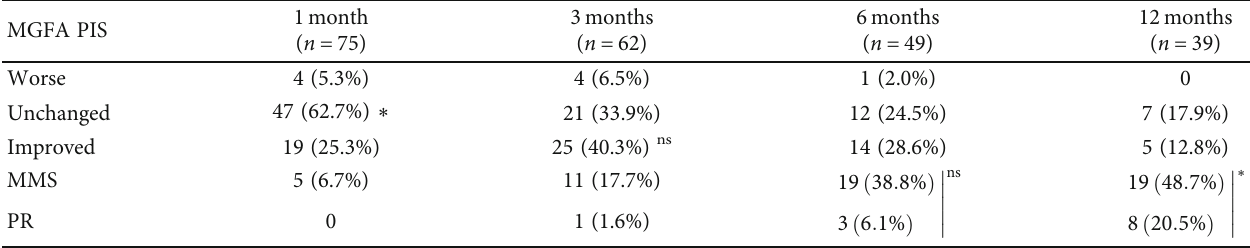
Table 3: The number and proportion of patients reaching each MGFA PIS at each follow-up time point. MGFA PIS